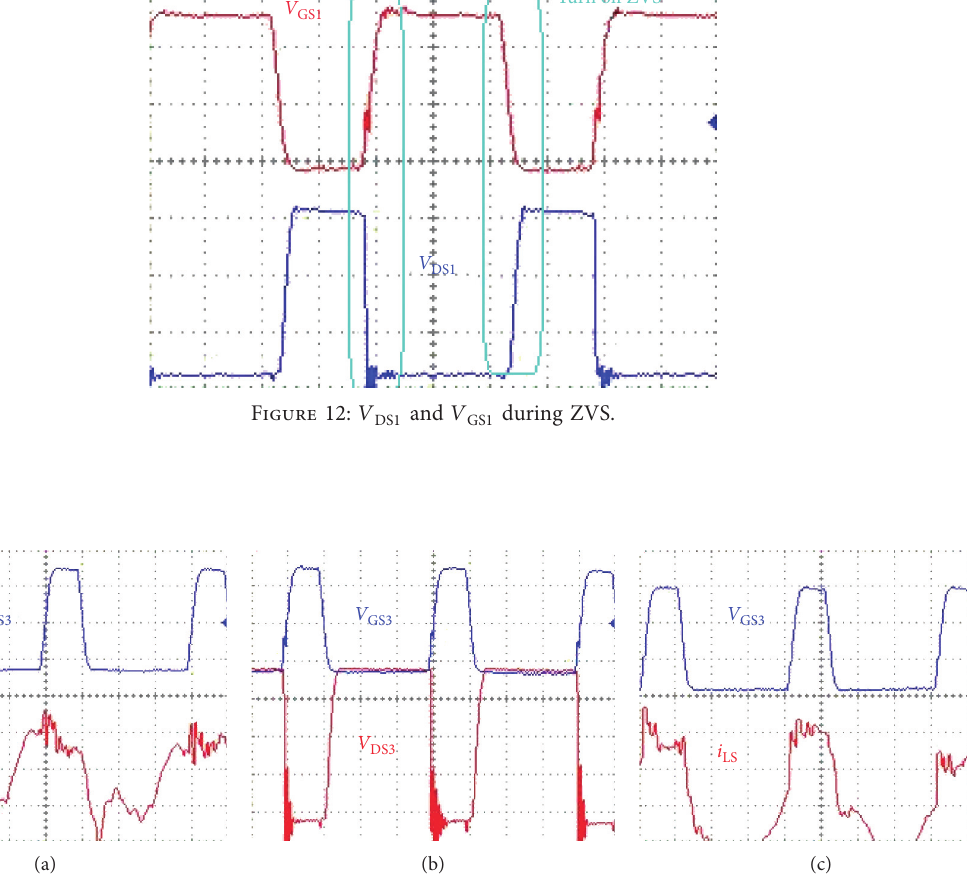
and magnetizing current GS3 . LS